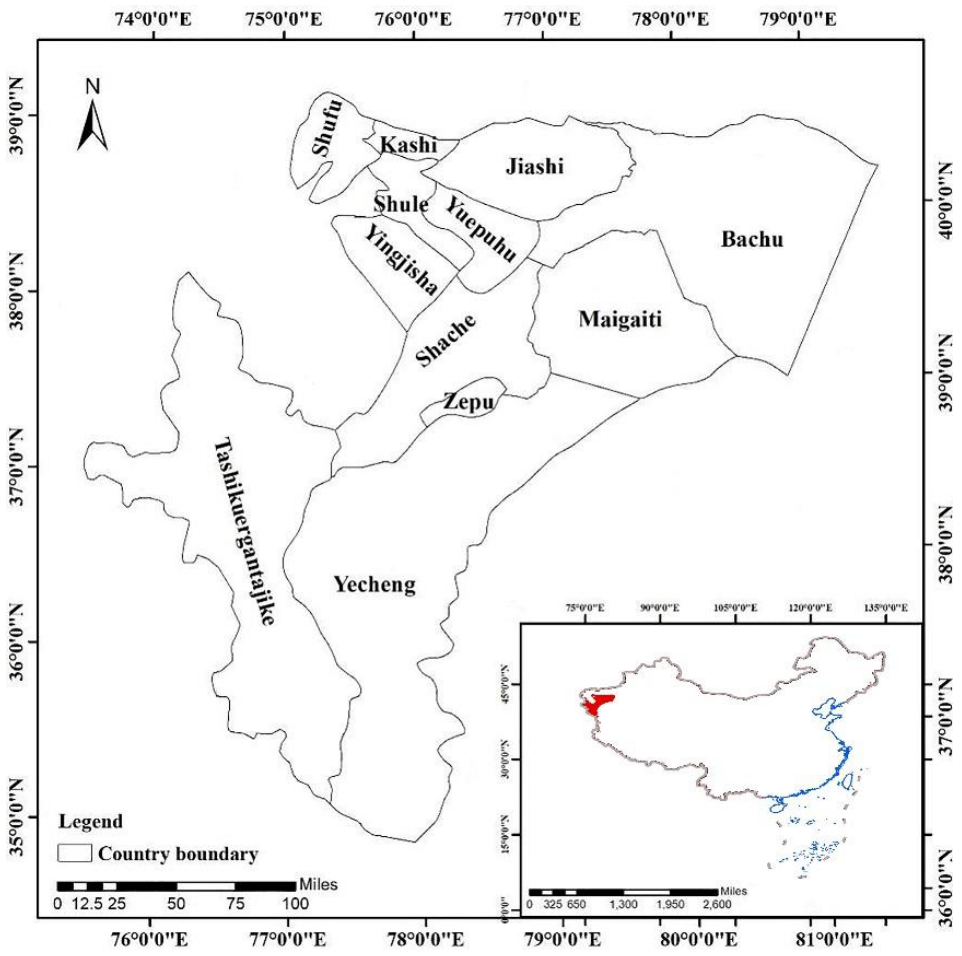
Figure 1. Study region, Kashi Prefecture and its counties.